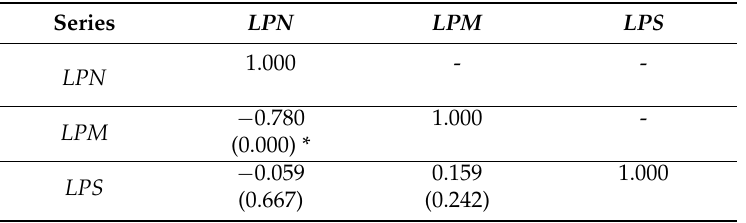
Table 3. Pairwise correlation matrix.